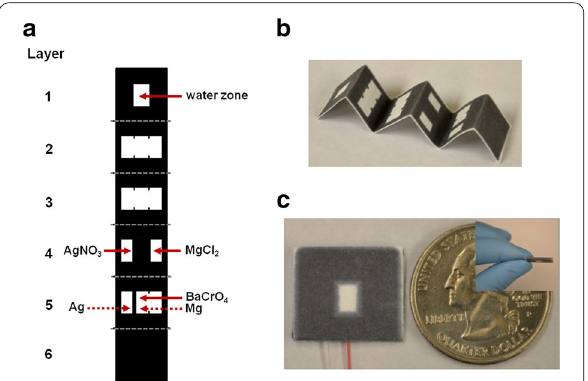
Fig. 4 Self‑powered paper microfluidic device, utilizing origami paper and galvanic cell, for enzymatic (alkaline phosphatase) fluo‑ rescent assay with smartphone detection: a device layout; b paper folding; c top and side view of final assembly (reprinted from [64] with permission, © 2014 AIP